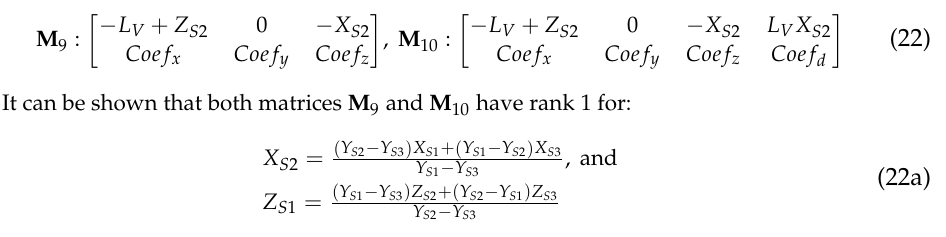
There are three general configurations for the 3-R-PRR-PRS parallel robot that correspond In Case 5, one side and the base of the characteristic tetrahedron are coplanar [30]. There are